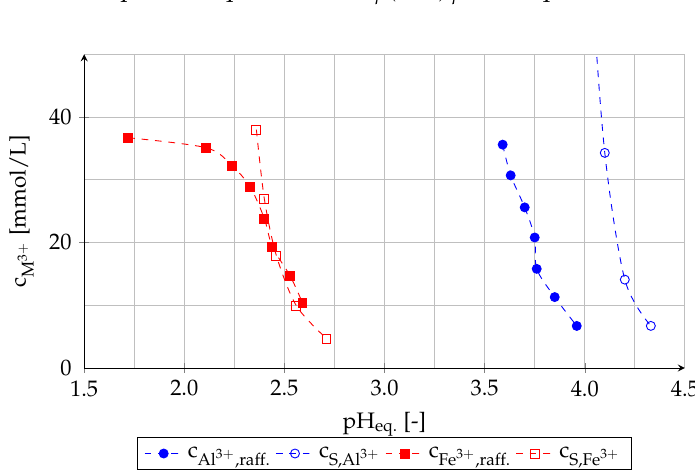
Figure 6. Concentration of aluminum and iron in the raffinate at the equilibrium (c c = 36 mmol/L) and solubility of metal ions determined in preliminary 0,Fe 3 +